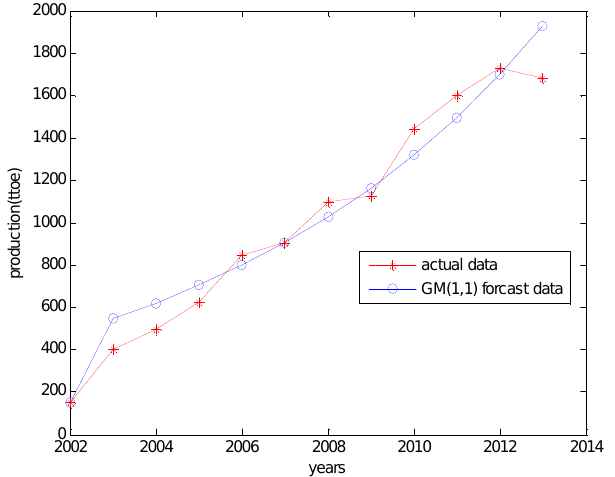
Figure 3. Prediction map of China’s biofuel production using the grey model GM (1,1) model.